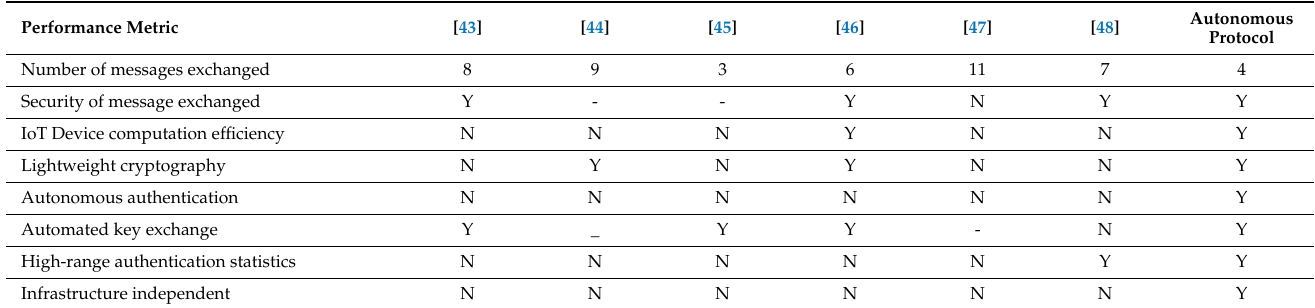
Table 6. Performance metric comparison of IoT security protocols.